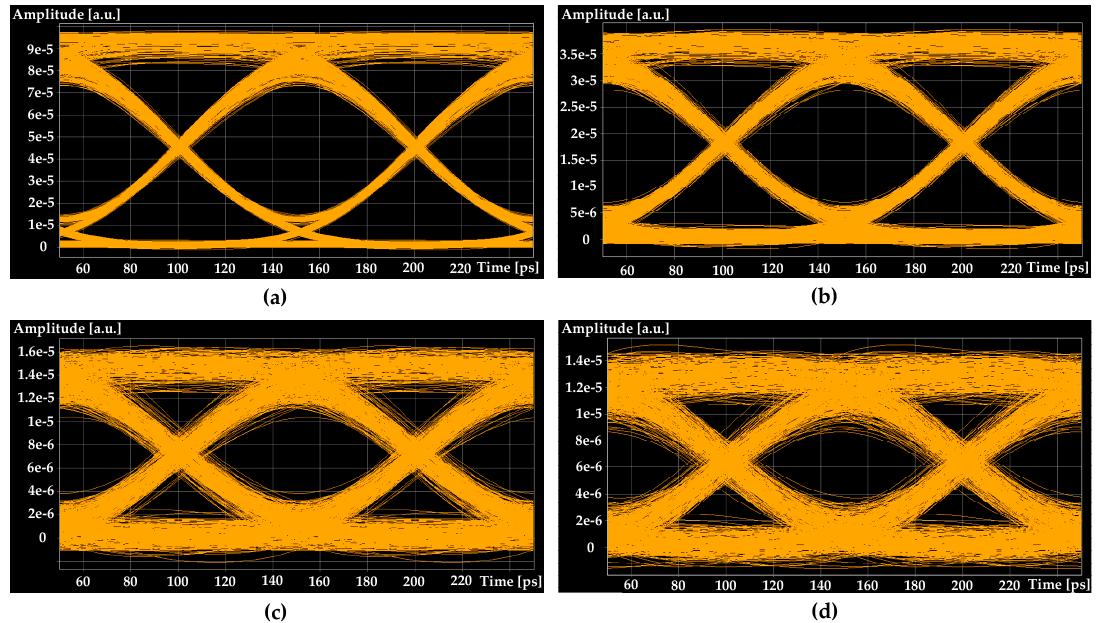
Figure 12. Eye diagrams of the received signal: ( a ) after B2B, ( b ) after 20 km, ( c ) after 40 km, ( d ) after 60 km transmission via SMF optical link section for investigated 4-channel 200 GHz spaced IM / DD WDM-PON system operating at 10 Gbit / s per channel.